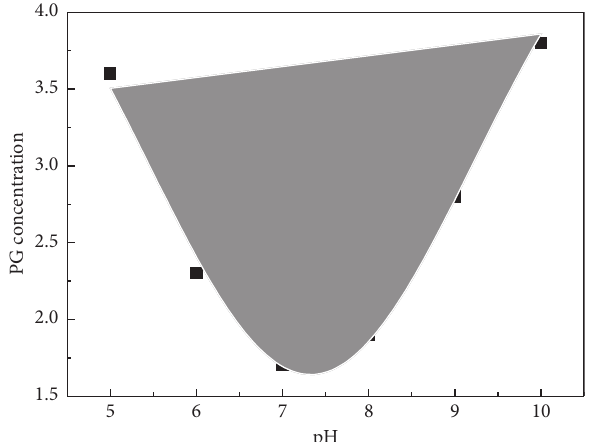
Figure 4: Dependence of foam stability on pH value and PG concentration (30 wt.% solid